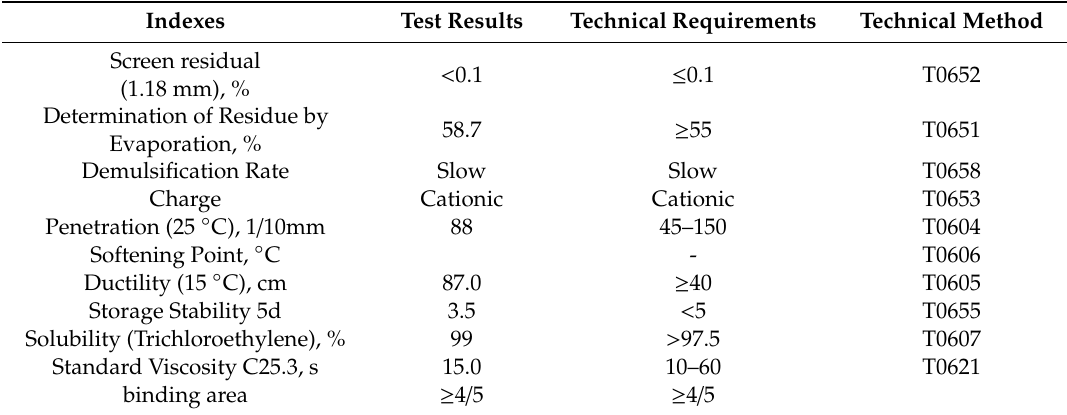
Table 1. Technical properties of emulsified asphalt.